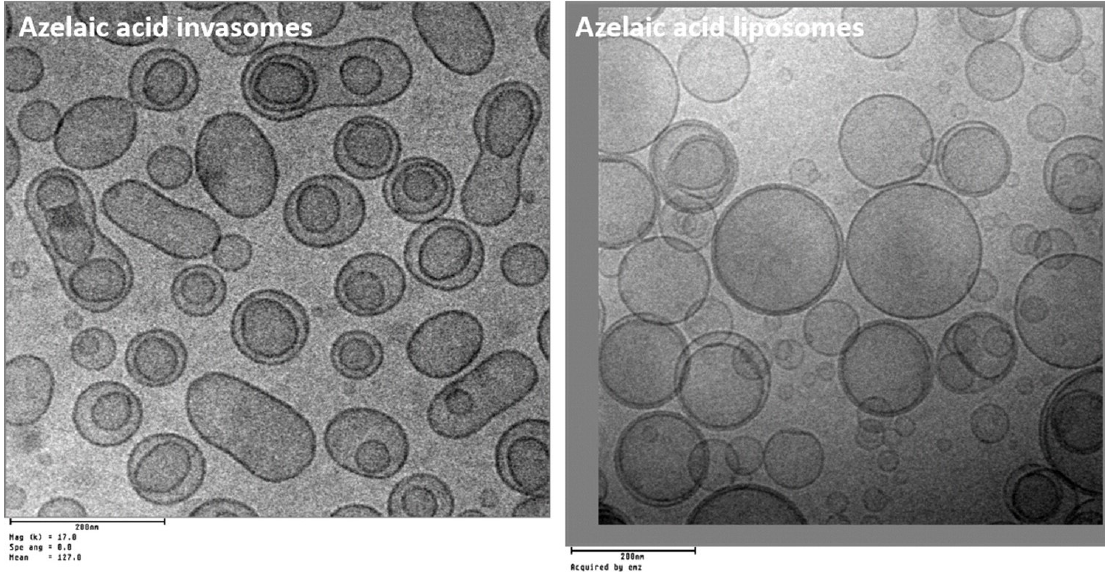
Figure 12. CryoTEM images of invasomes and liposomes loaded with azelaic acid [253]. Copyright 2015